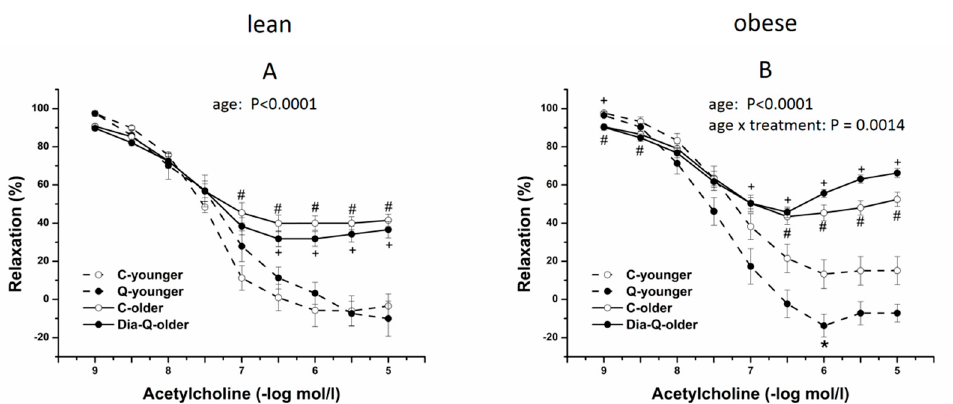
Figure 3. The endothelium-dependent vasorelaxant responses of thoracic aorta induced by acetylcholine in lean ( A ) and obese ( B ) rats. Results are expressed as mean ± SEM. Significant di ff erences were evaluated by two-way ANOVA for main factors diabetes and quercetin treatment (shown for maximal relaxation). Tukey post hoc test was used to describe the di ff erences in mean values of the experimental groups. # p < 0.05 vs. C-younger; + p < 0.05 vs. Q-younger.